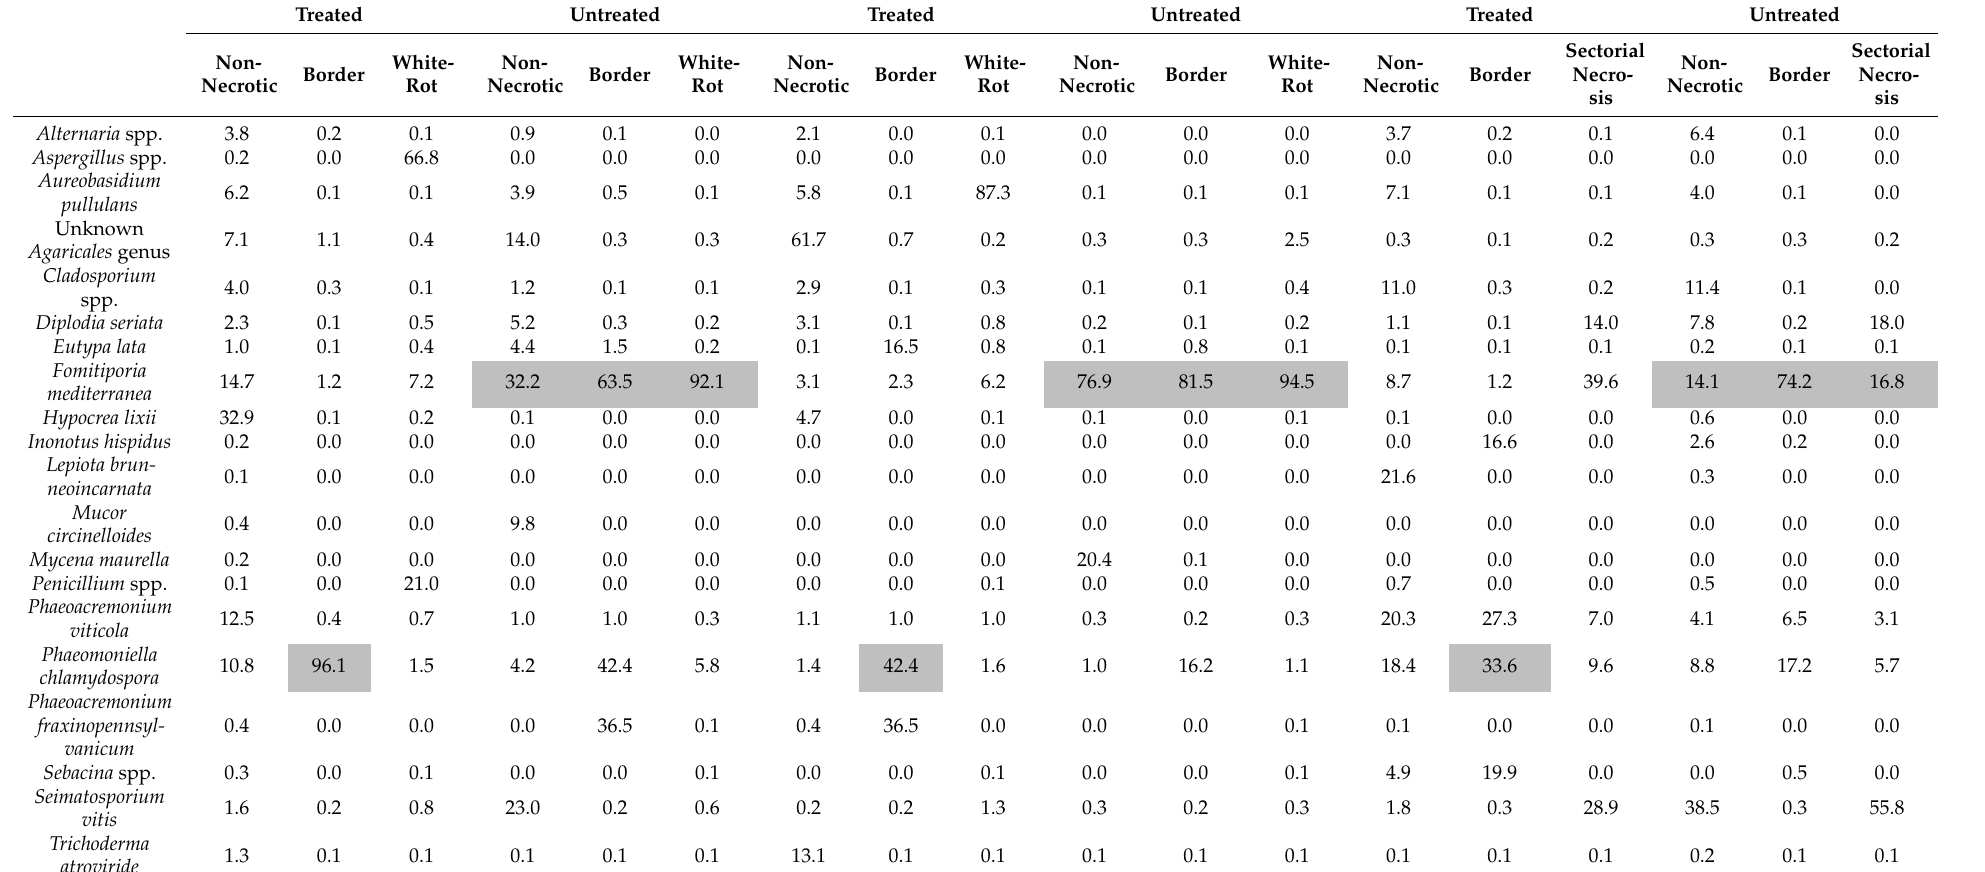
Table 3. The 20 most abundant fungal species identified in woody tissue of grapevines from Alsace, Champagne, and Languedoc, using metabarcoding. Highest percentages are highlighted in gray. % of reads for a single species, in gray values over 10%. Treated Untreated Treated Untreated Treated Untreated White- Non- White- Non- White- Non- Non- Border Border Border Border Rot Necrotic Rot Necrotic Rot Necrotic Necrotic Alternaria spp.